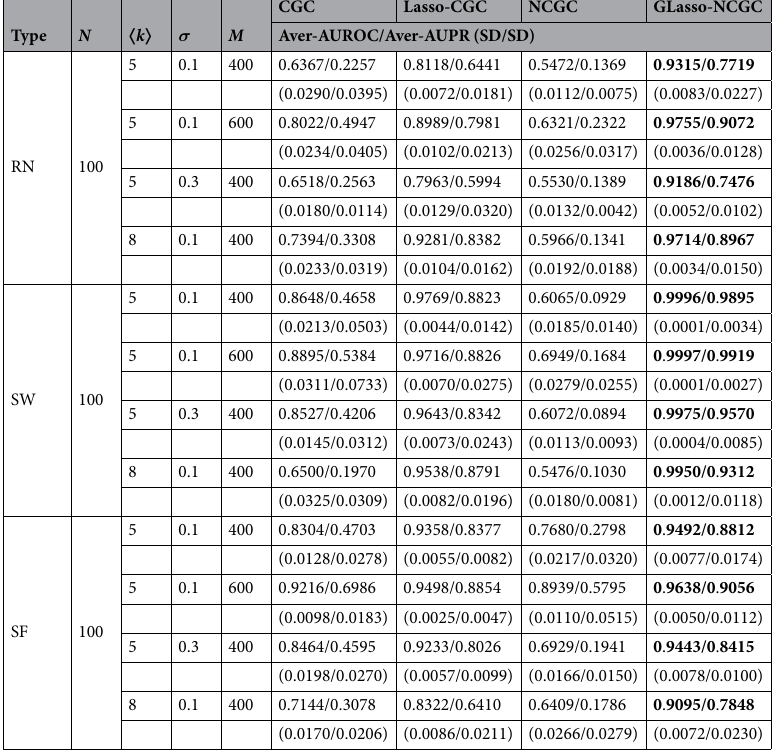
Table 4. The Average AUROC and Average AUPR with standard deviation in parentheses of different methods based on three types of networks, random (RN), small-world (SW) and scare-free (SF). The values are computed by averaging over 10 independent realizations. The results of different methods at different conditions are explored (type, N , 〈 k 〉 , σ and M ). Here, N is the size of network, 〈 k 〉 is average degree of network, σ is gaussian noise intensity, M is the number of samples. The highest scores of the Average AUROC and Average AUPR are highlighted.